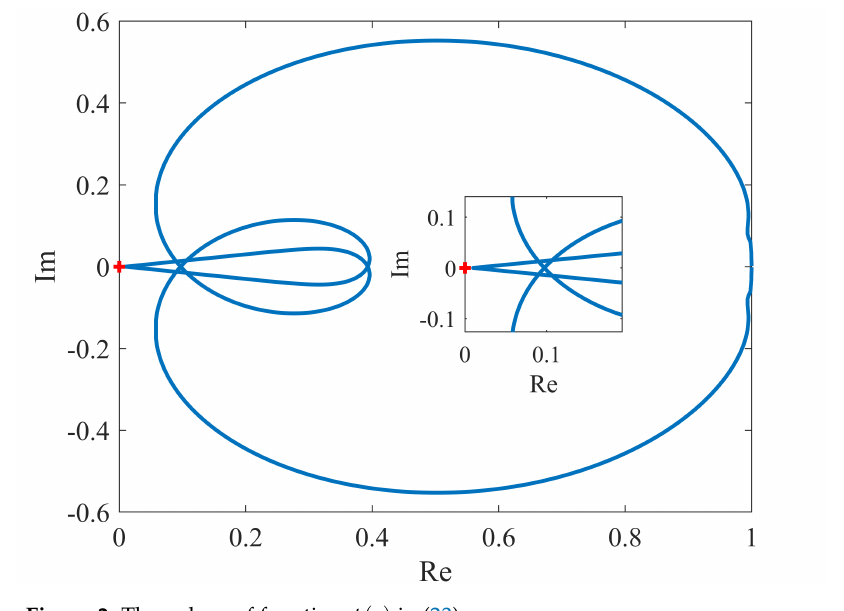
Figure 2. The values of function ψ ( s ) in (23).